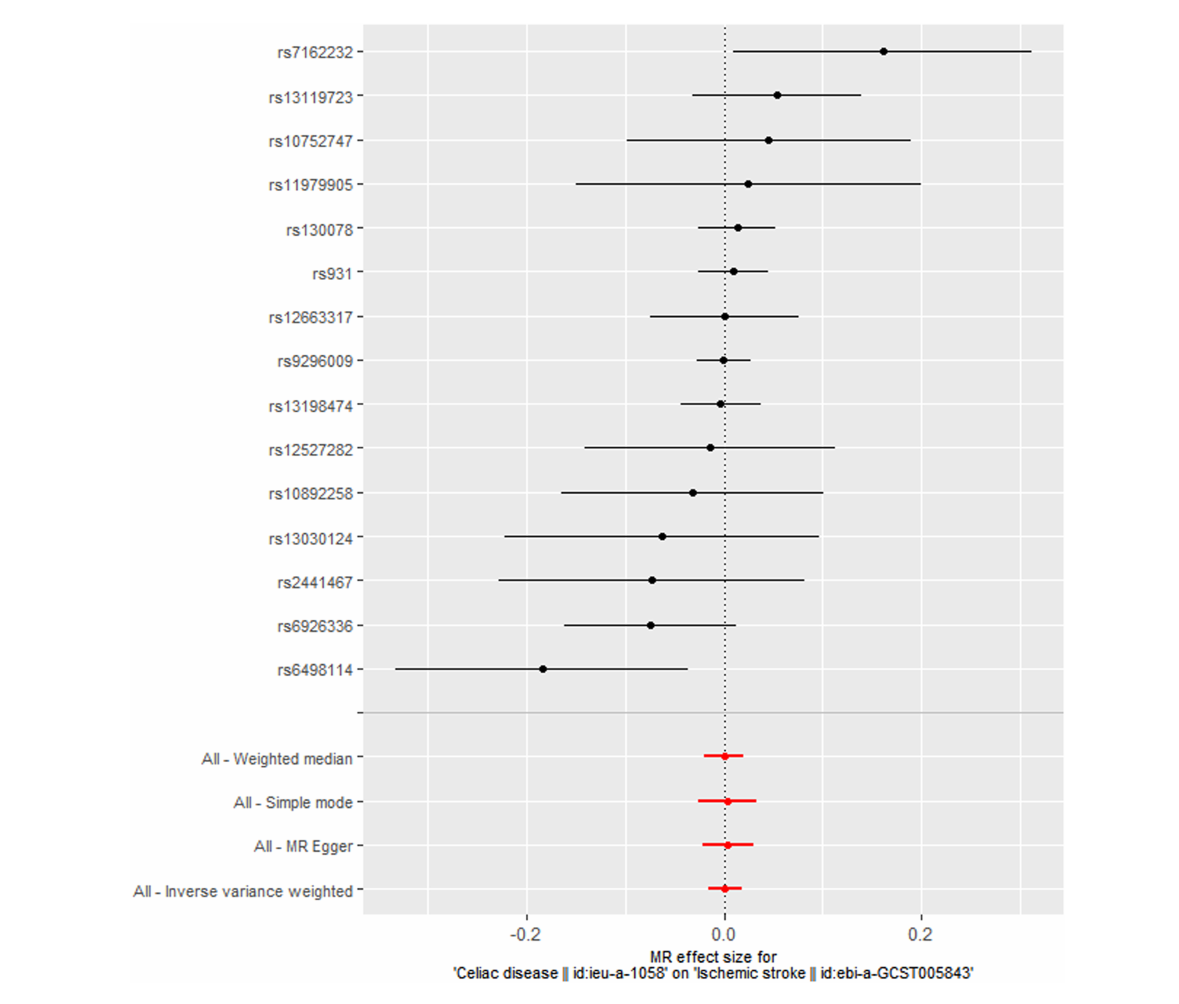
FIGURE1 Meta-analytic mendelian randomization (MR) effect estimates and 95% confidence intervals for the association between celiac disease and ischemic stroke. The inverse variance weighted (IVW) method was applied in the main MR estimate. Sensitivity analyses were performed using the MR-Egger, weighted median, and simple mode